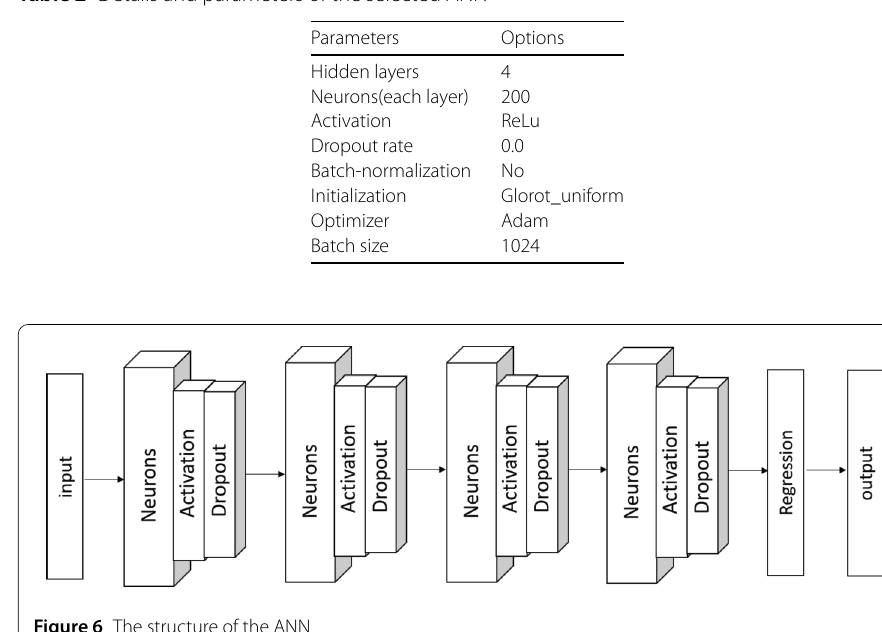
Table 2 Details and parameters of the selected ANN